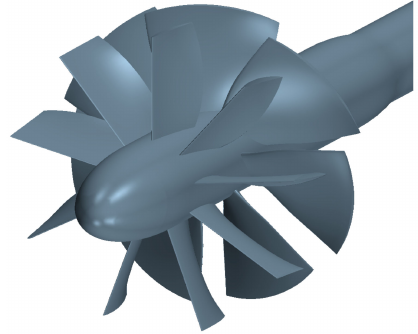
Figure 1. The geometric model of the seven-bladed rotor and the nine-bladed pre-swirl stator. The stator blades are connected to the shroud surface without clearance. The shroud surface is omitted.